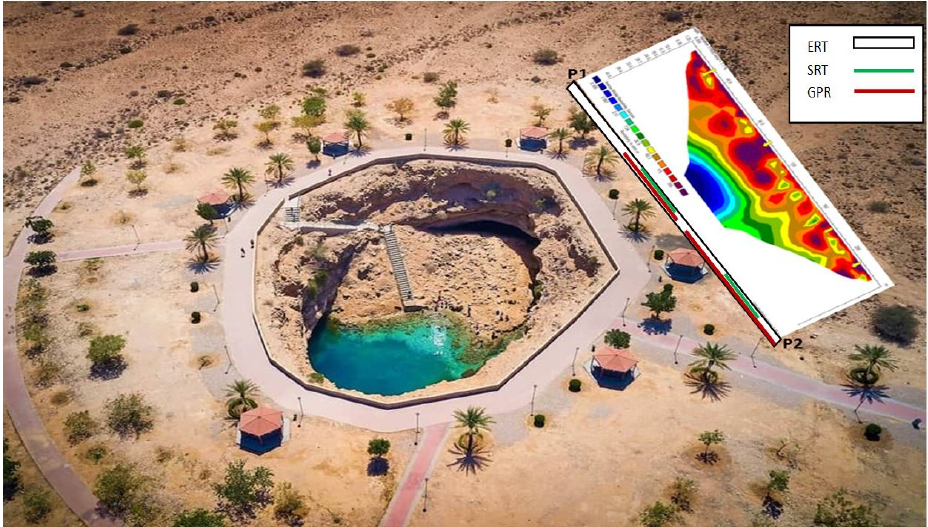
Figure 3. Area of study and study line and electrical resistivity section. A detail of relative position of different methods can be seen in Figure 9.